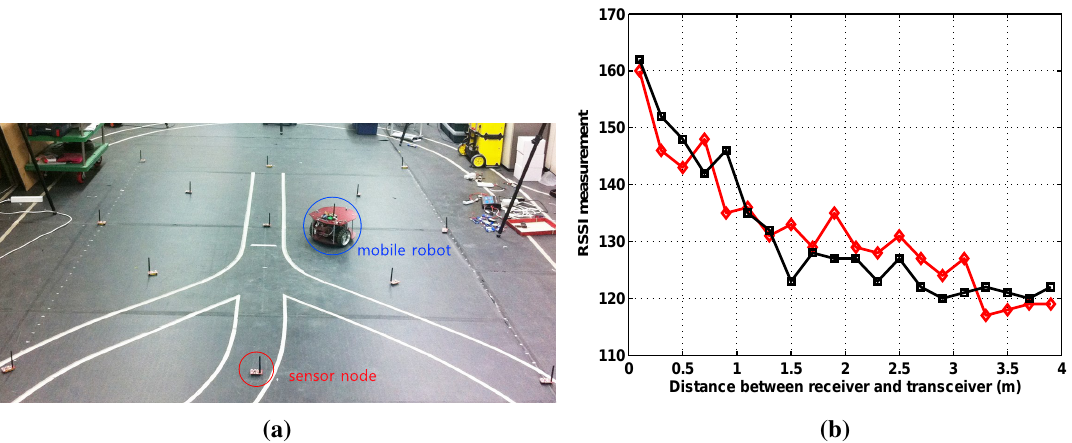
Figure 1. ( a ) Experimental setup with one mobile robot and thirteen sensor nodes. The